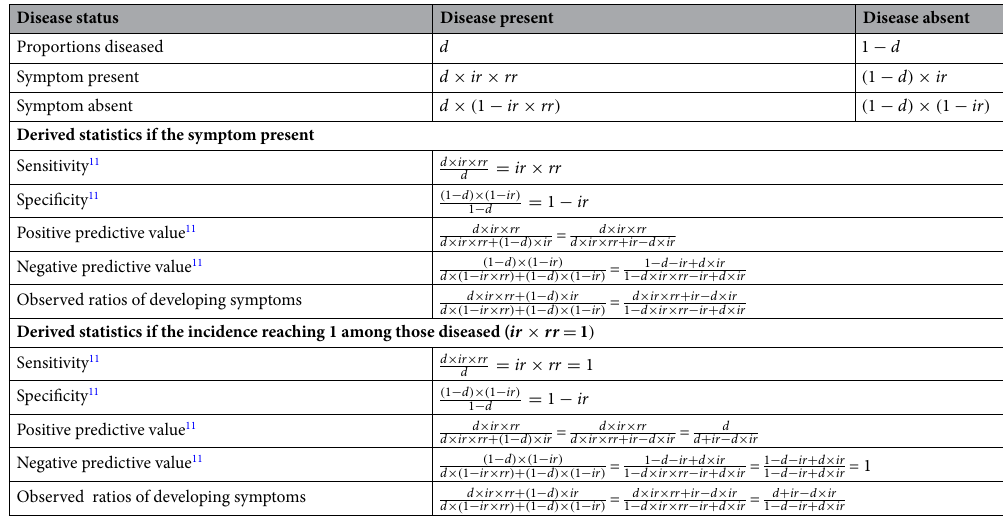
Table 1. Diagnostic accuracy of a single symptom to diagnose the disease cause in equations. Equations are derived based on Baratloo et al.’s definitions 11 . d proportions in a population with the disease, ir symptom incidence rate, rr risk ratios.